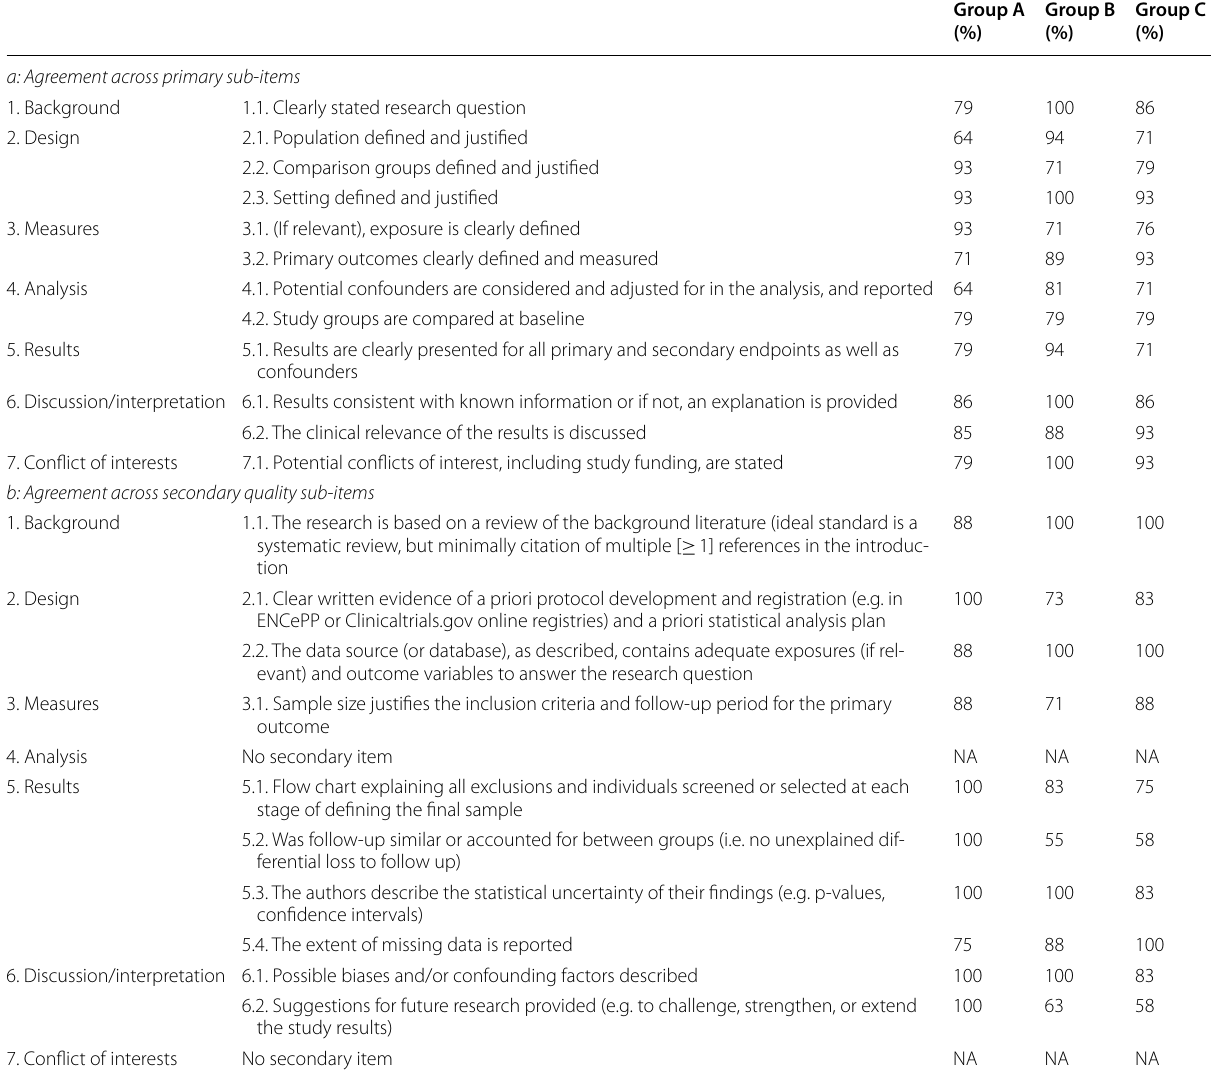
Table 2 Extended Pilot Item level agreement